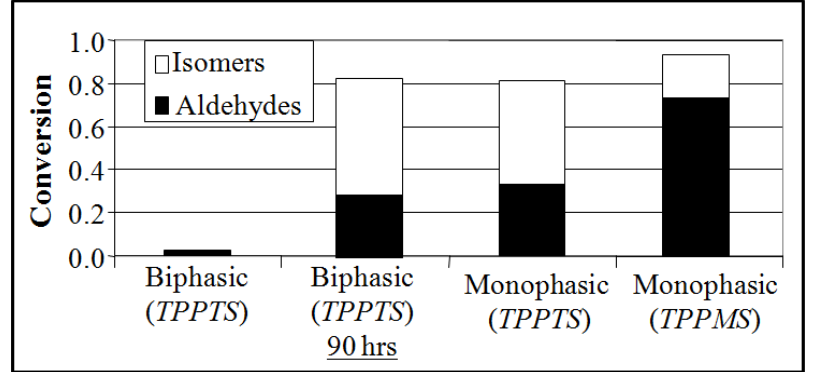
Figure 3. Conversion and yield of 1-octene hydroformylation at 120 °C and 1 h